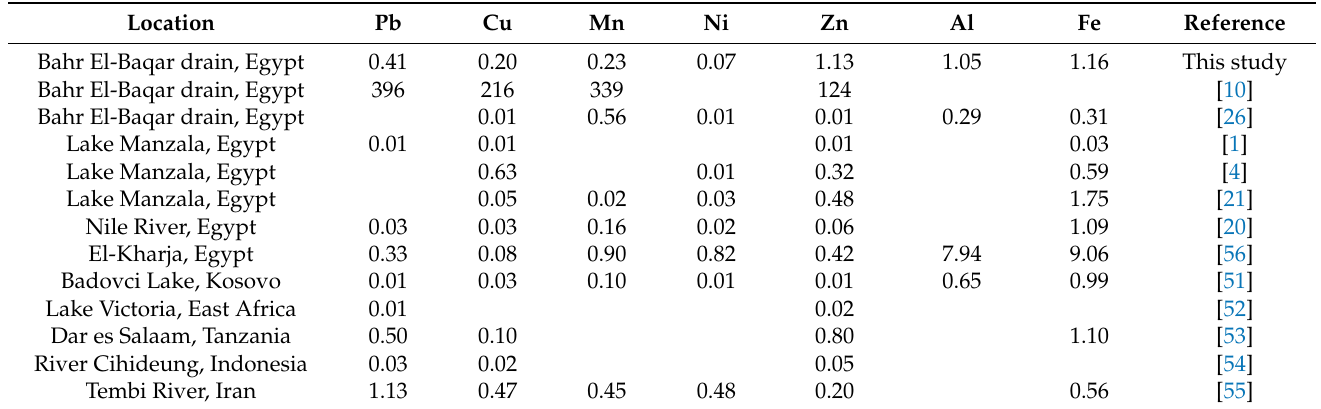
Table 2. Average concentrations of heavy metals (mg/L) in the studied water samples compared to those of national and international